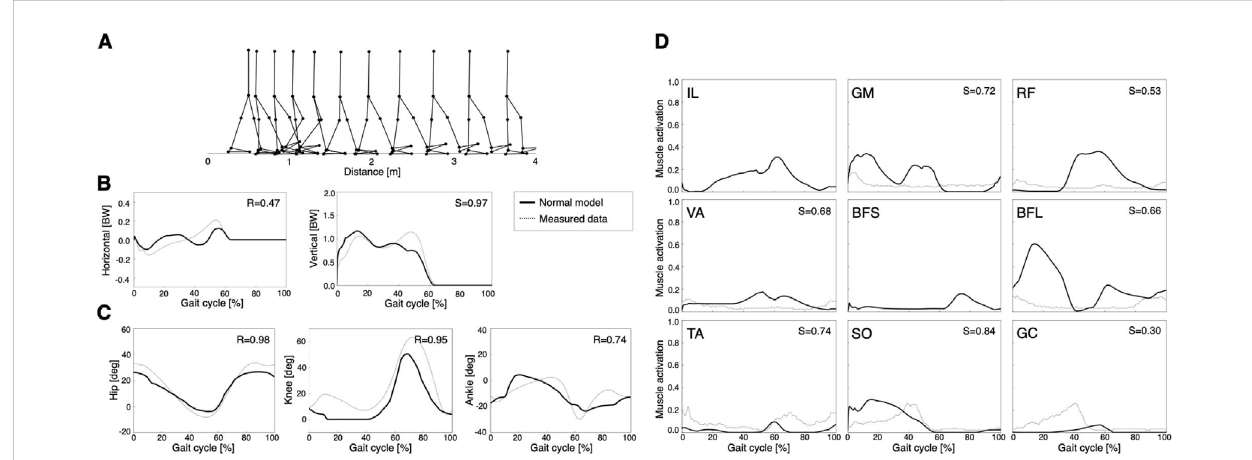
FIGURE 2 Simulation results of the normal model: (A) stick diagram of the normal model, (B) ground reaction forces, (C) joint angles, and (D) muscle activations. A gait cycle is the period of events during locomotion in which one foot contacts the ground until the same foot contacts the ground again. Dashed lines represent the measured data (Bovi et al., 2011). Solid lines indicate the right limb in the normal model. R is the correlation coef fi cient, and S represents cosine similarity.